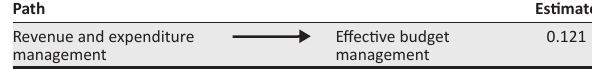
TABLE 13: Revenue and expenditure management (Hypothesis 2).